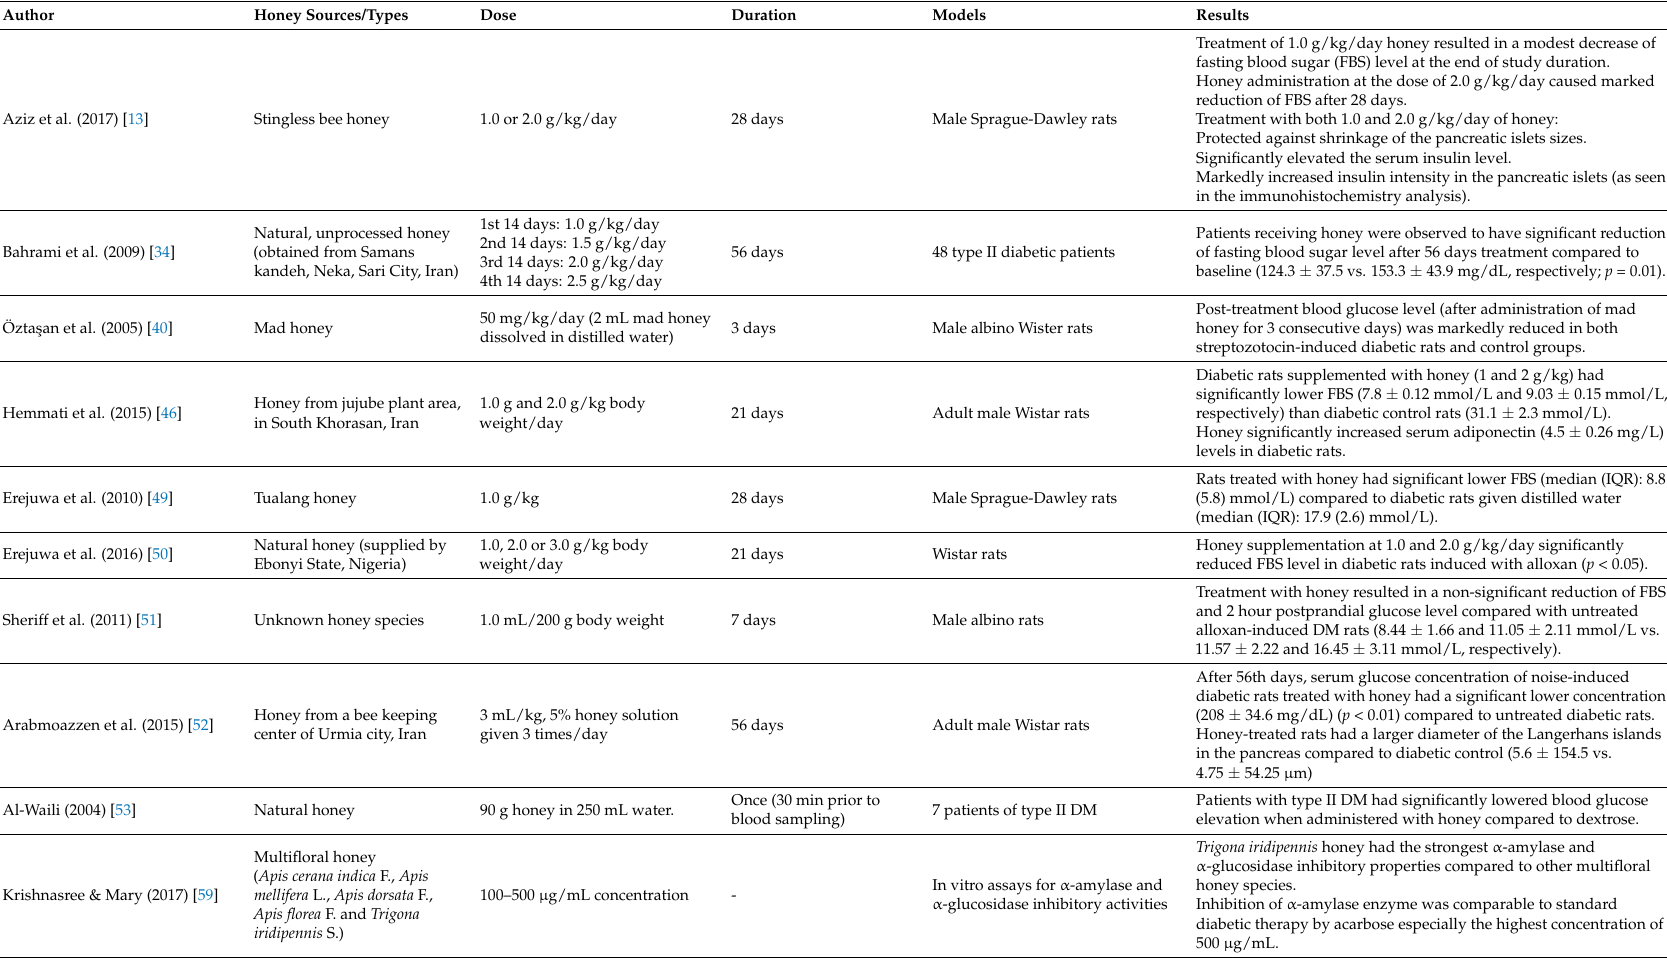
Table 2. Anti-diabetic effects of honey in clinical and pre-clinical